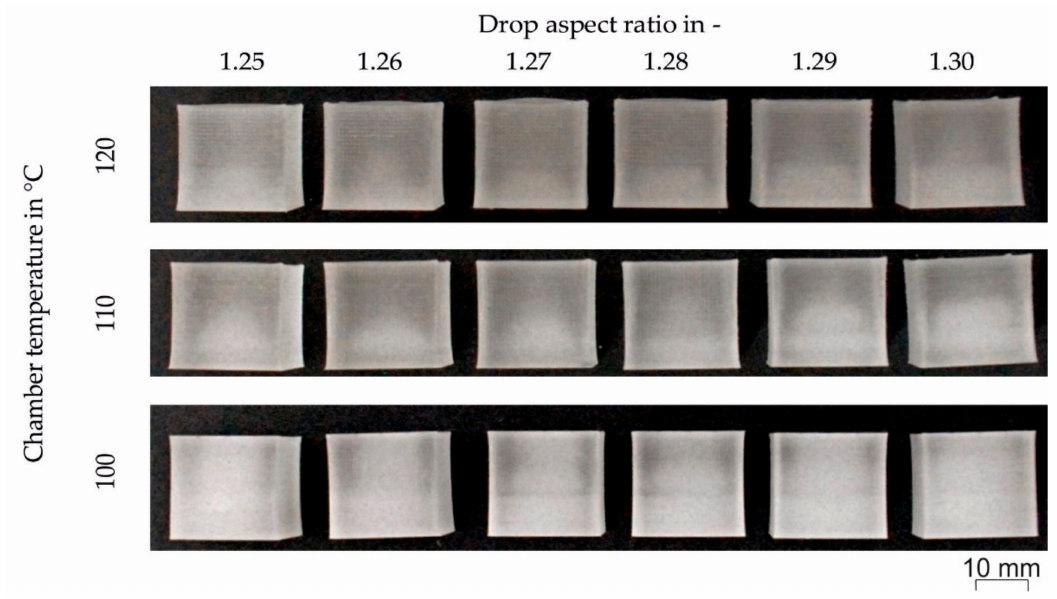
Figure 5. Printed cubes with six di ff erent values for the drop aspect ratio between 1.25 and 1.30, and three di ff erent chamber temperatures (T chamber ) and decreased drop overlap of 25%. Other processing temperatures were T 1 = 200 ◦ C, T 2 = 230 ◦ C, and T nozzle = 245 ◦